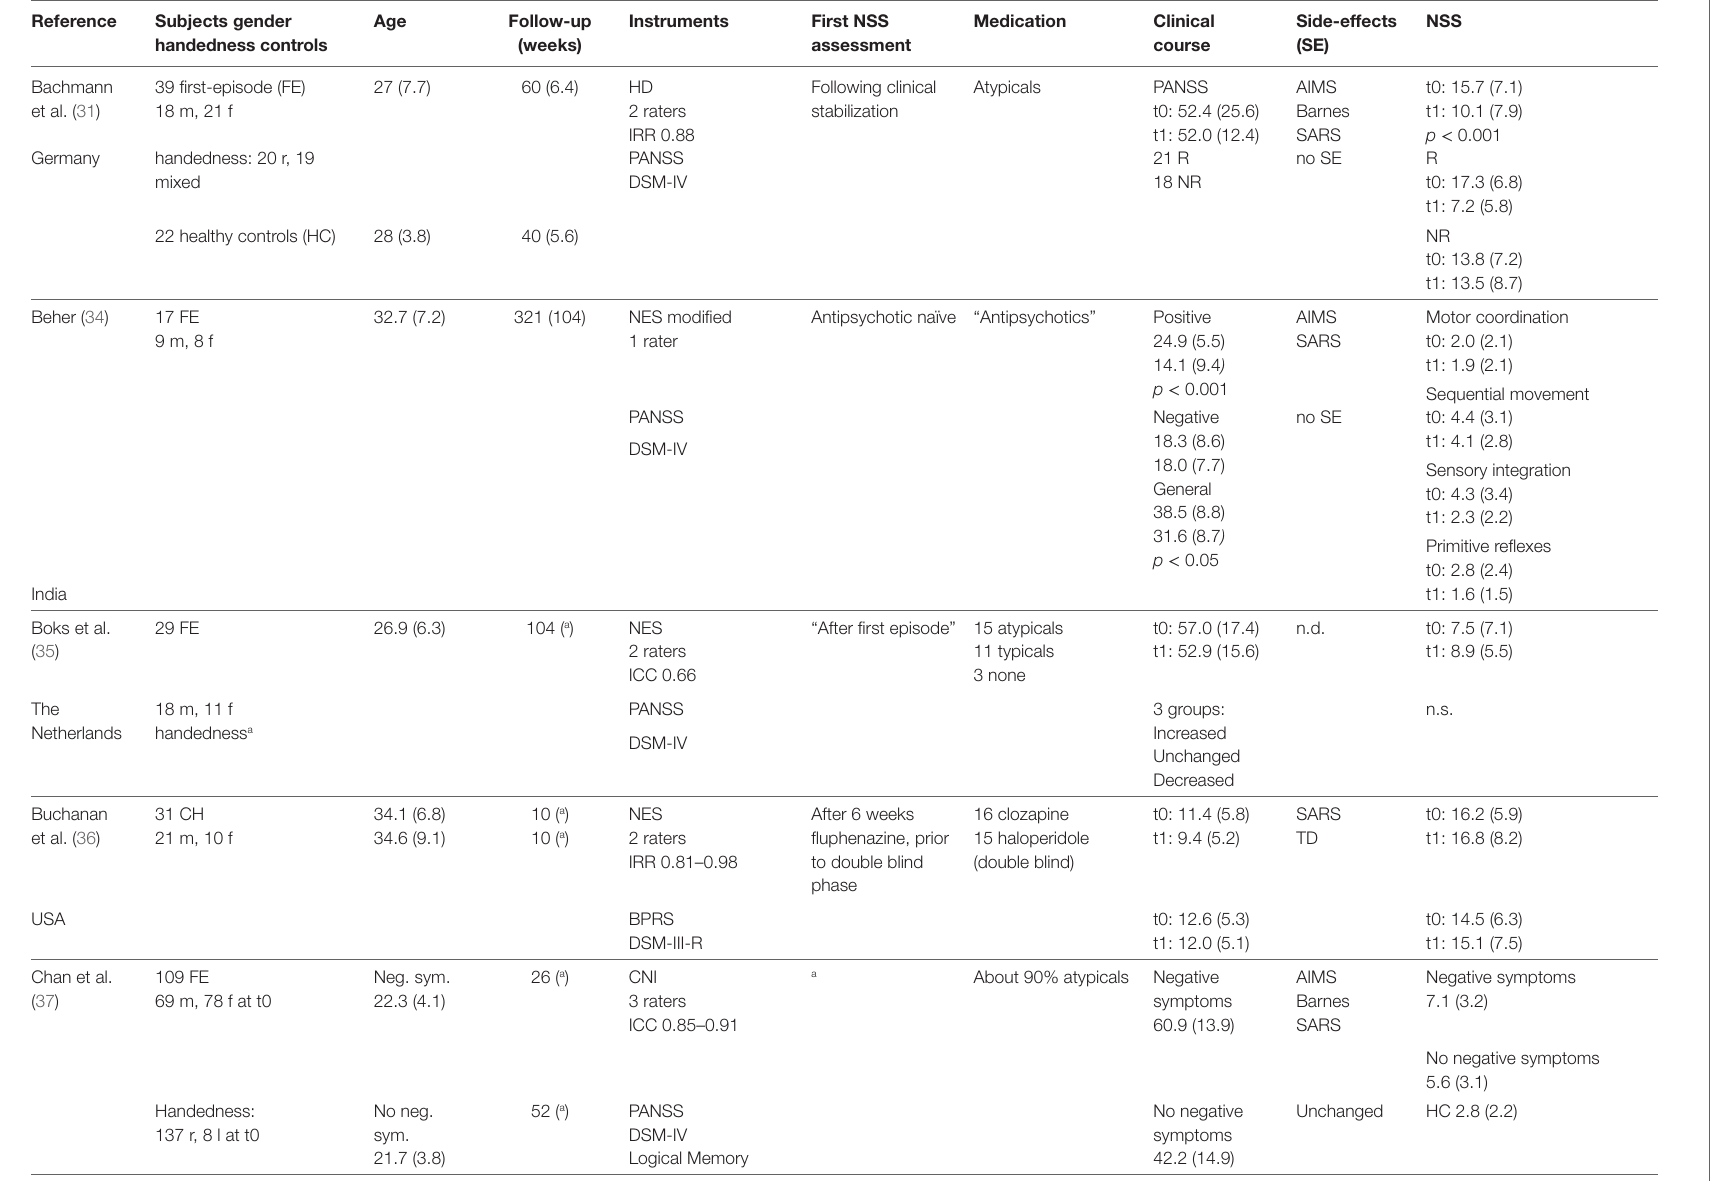
TABle 1 | Longitudinal studies on patients with schizophrenia in alphabetical order. Reference Follow-up